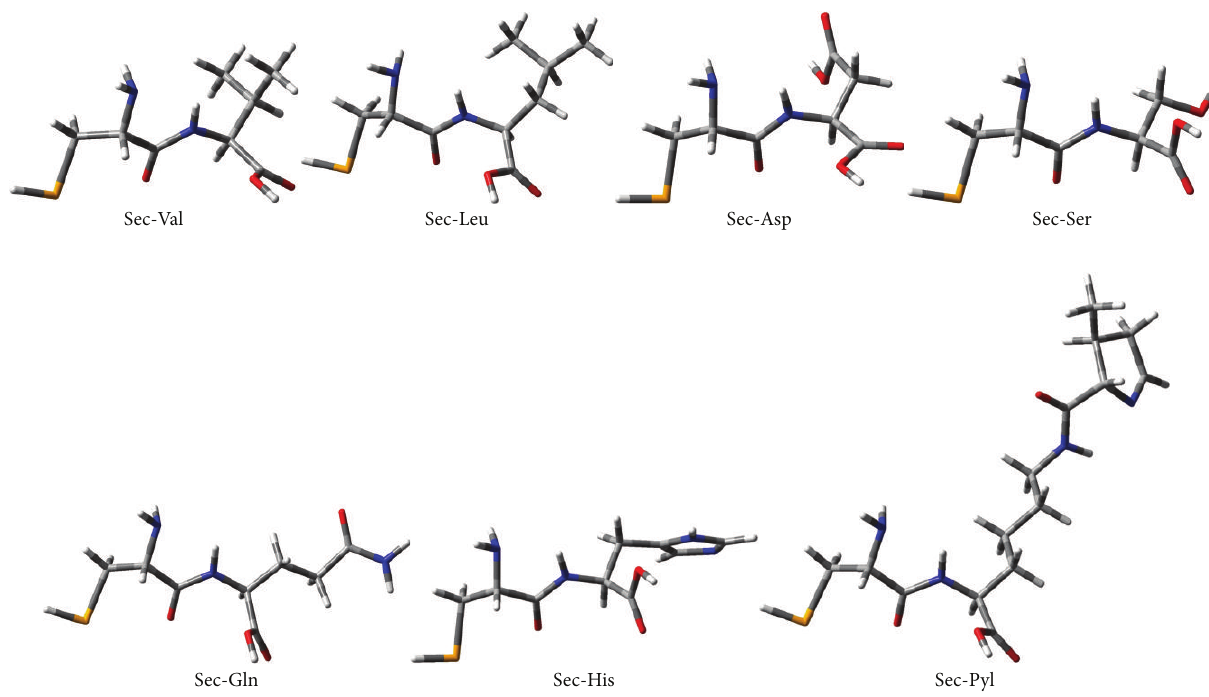
Figure 3: Optimized structures of the dipeptides in aqueous phase.